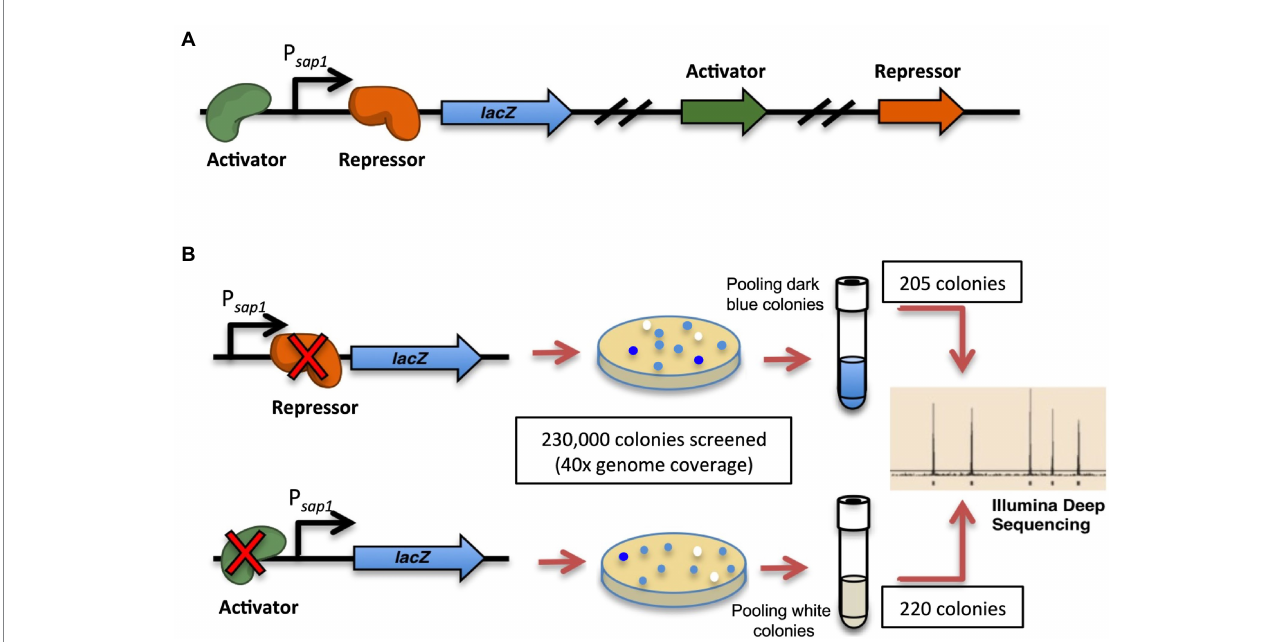
FIGURE 2 Strategy to identify potential sap1 regulator(s): high-throughput transposon mutagenesis and Tn-Seq. (A) A reporter strain was generated with a single-copy integration of a P sap1 - lacZ fusion at a neutral site on the chromosome of B0011 strain. (B) Random mutagenesis was performed on the reporter strain using mariner transposon pBT20- gat . A total of 230,000 transposon mutant colonies, approximately 40 × coverage of genome, were screened for their β -galactosidase activities. Colonies with higher (205) and lower (220) expression of β -galactosidase activity were pooled separately and the transposon junctions were identified by Tn-Seq.